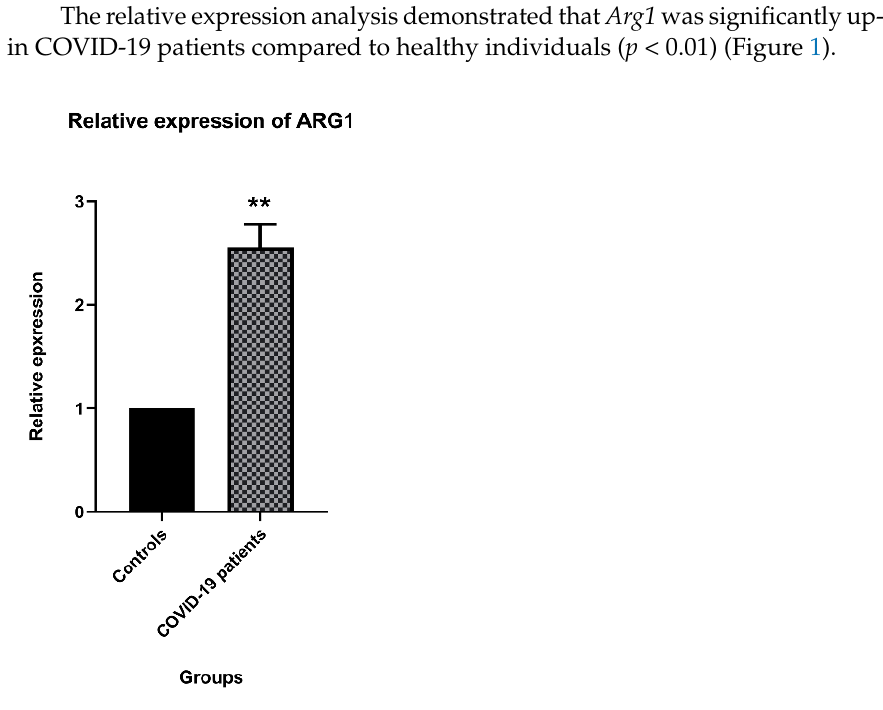
Figure 1. The expression of Arg1 in coronavirus disease 2019 (COVID-19) patients compared to the control group. The relative expression of Arg1 in COVID-19 patients was 2.3 times more than in healthy groups. (** p < 0.01).